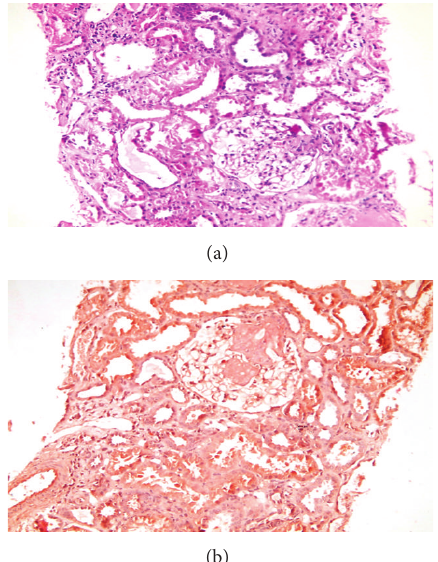
Figure 2: (a) Kidney biopsy (H&E stain). (b) Kidney biopsy (Congo red